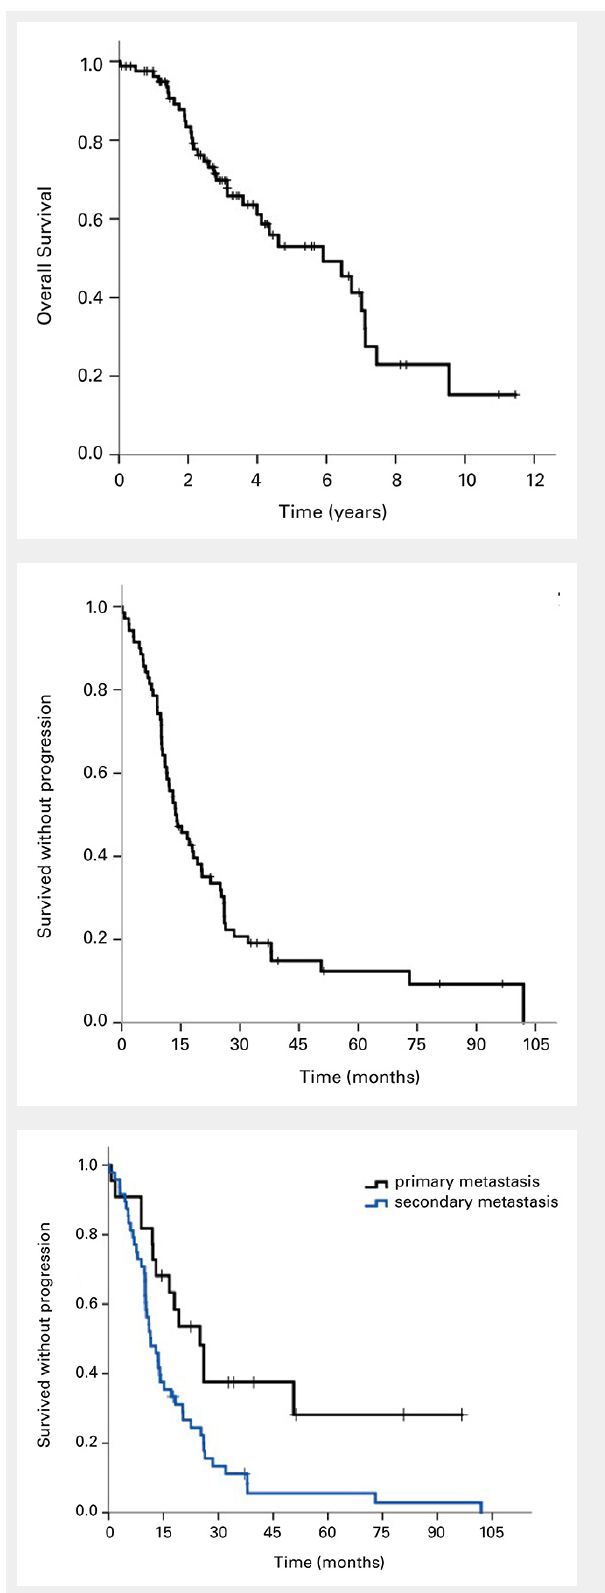
Figure 1 Kaplan-Meier curves for ( a ) overall survival for all patients, ( b ) progression-free survival (n = 70), and ( c ) progression-free survival of patients with primary metastatic disease vs patients with secondary metastatic disease, p =